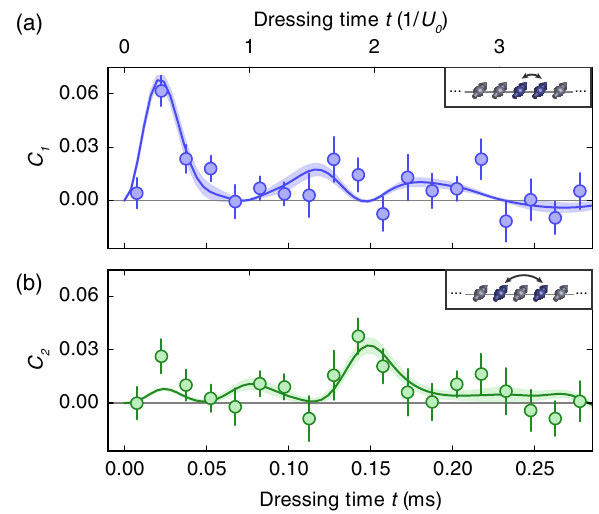
FIG. 3. Local characterization of the spin dynamics. (a) Ob- served evolution of the connected correlations C d for spins separated by d ¼ a and (b) d ¼ 2 a , as indicated by the lat lat pictograms. The solid line with surrounding shading shows the corresponding prediction of the same theoretical calculation as used in Fig. 2. All error bars denote one